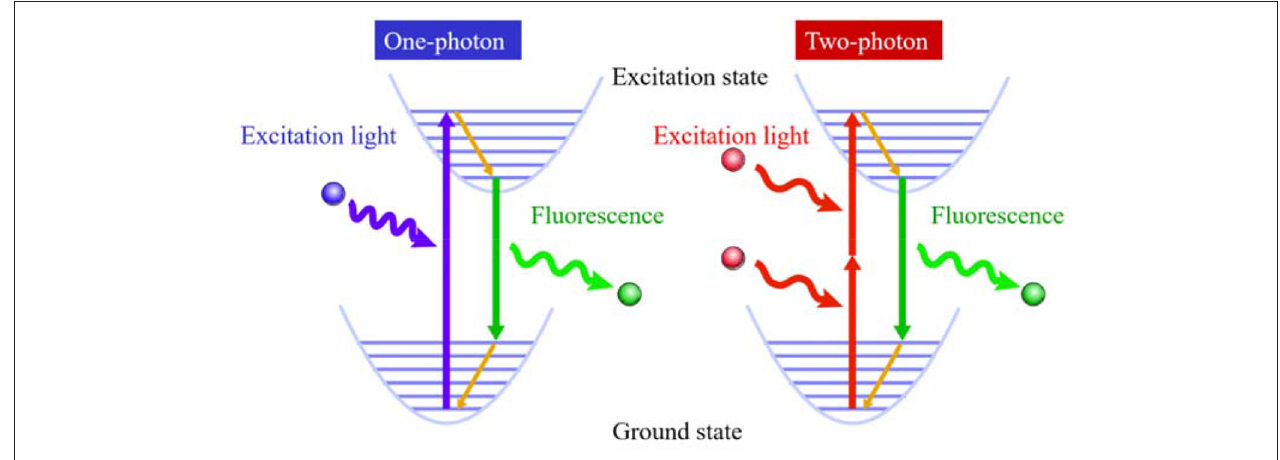
SCHEME 1 | Principle of two-photon excited fluorescence for